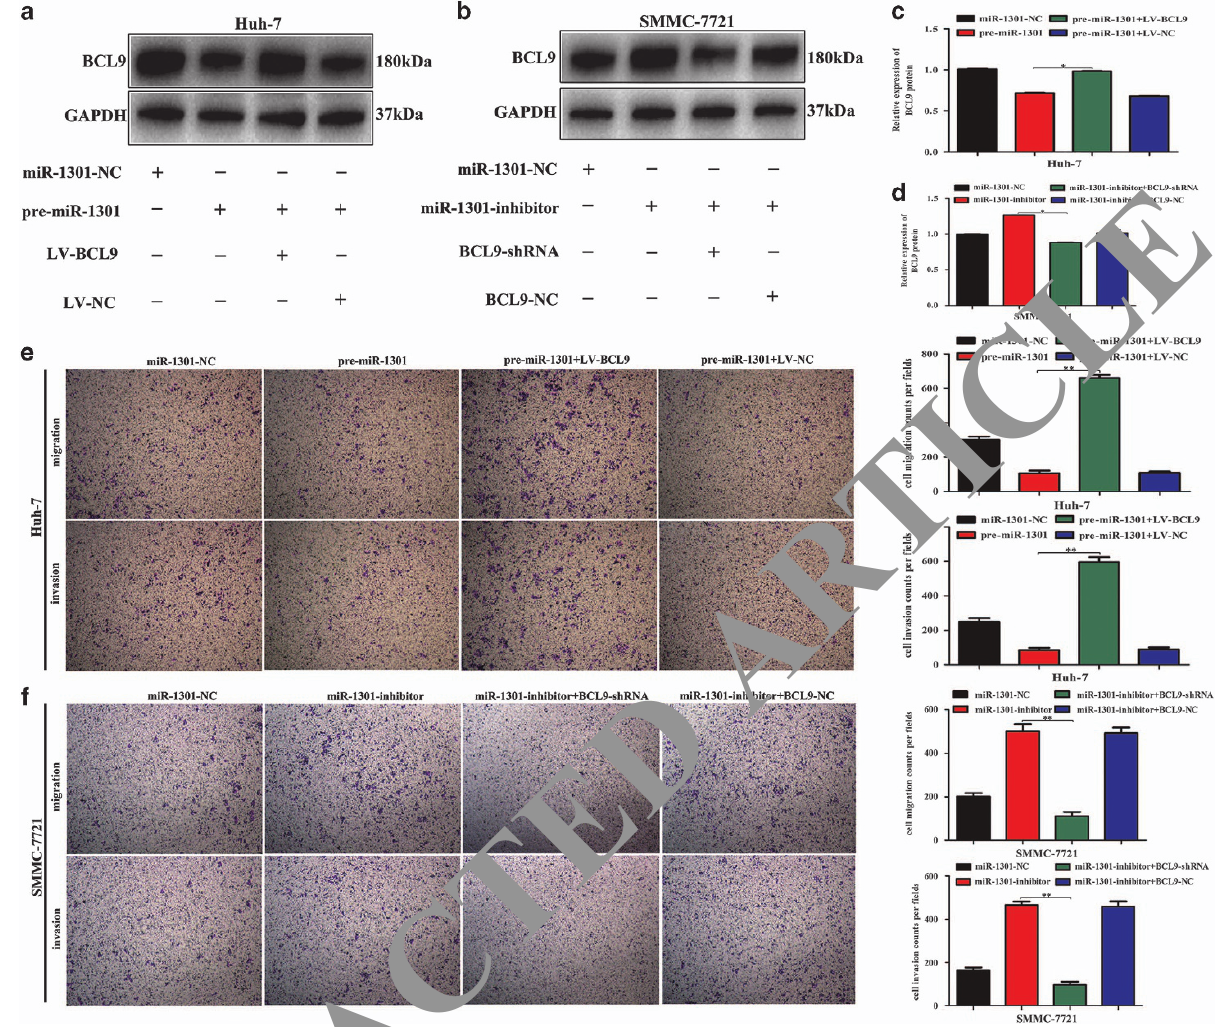
Figure 6 BCL9 overexpression eliminates the inhibitory effects of miR-1301 on HCC cell migration and invasion. ( a – d ) Western blotting was conducted to examine BCL9 protein expression in the indicated cells. ( e and f ) miR-1301 upregulation suppressed Huh-7 cell migration and invasion. The rescue experiments for miR-1301 overexpression were performed by ectopically expressing BCL9 (LV-NC). miR-1301 silencing was counteracted by downregulating BCL9, which was observed in SMMC-7721 cells. Cell migration and invasion capability were quantified as cell numbers. All experiments were performed three times, and representative data are displayed as mean ± S.D. * P o